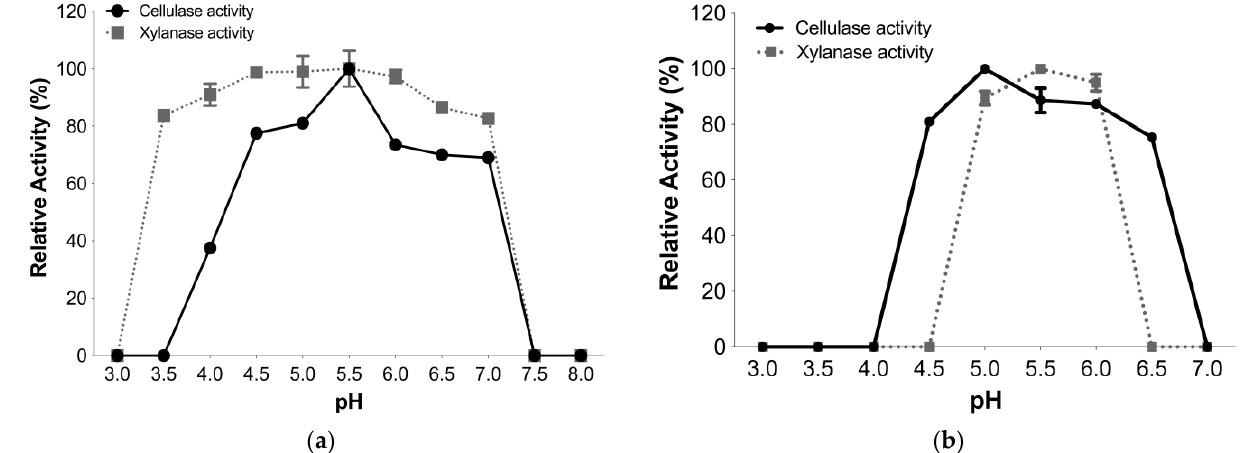
Figure 4. Influence of pH and temperature of TtCel7A. ( a ) pH effect using different buffers: citrate (pH 3–6), acetate (pH 4–5.5), citrate-phosphate (pH 3–7), and phosphate (pH 5.5–8) incubated at 60 ◦ C and 10 min for cellulase activity and 50 ◦ C and 15 min for xylanase activity. ( b ) Influence of pH stability on TtCel7A incubated in citrate-phosphate buffer (pH 3–7) at 25 ◦ C for 60 min for cellulase and 30 min for xylanase activity.